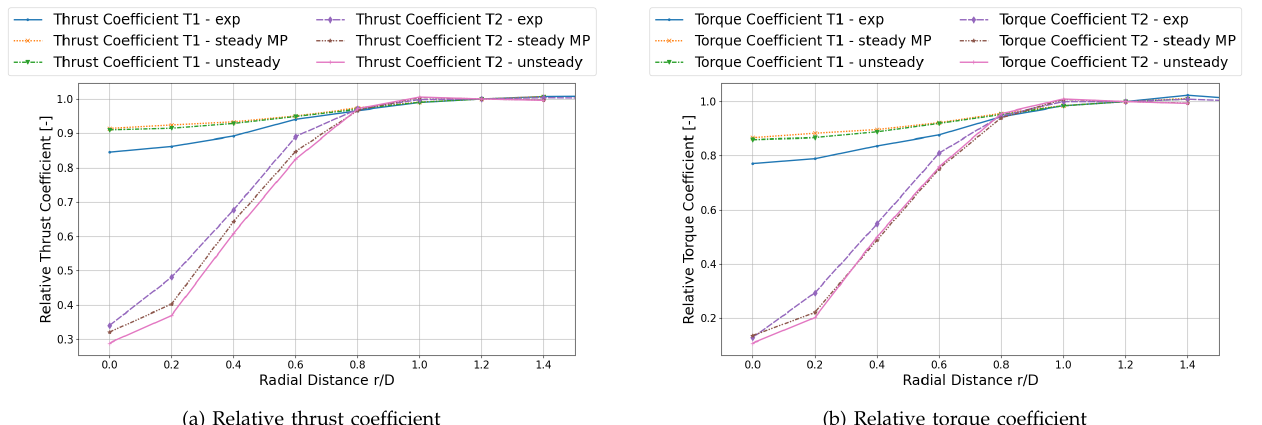
Fig. 8. Relative thrust and torque coefficient of experiment and simulations. Coefficients relative to results of case r/D = 1 . 2 . T1: upstream turbine. T2: downstream turbine. exp: experimental data. steady MP: steady state simulation with mixing plane interface. unsteady: unsteady simulation.